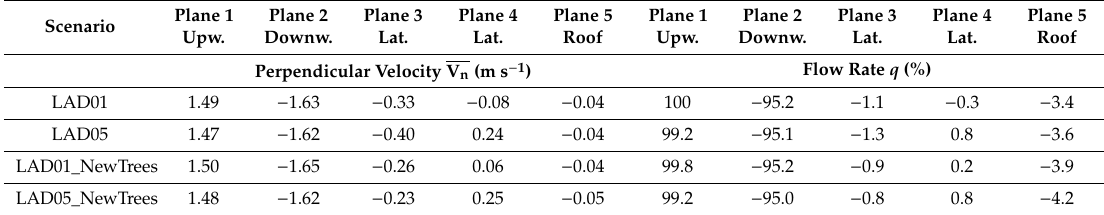
Table 3. Average perpendicular velocity V n and percentages of the total flow rates at each plane. Plane 1 Plane 2 Plane 3 Plane 4 Plane 5 Plane 1 Scenario Upw. Downw. Lat. Lat. Roof